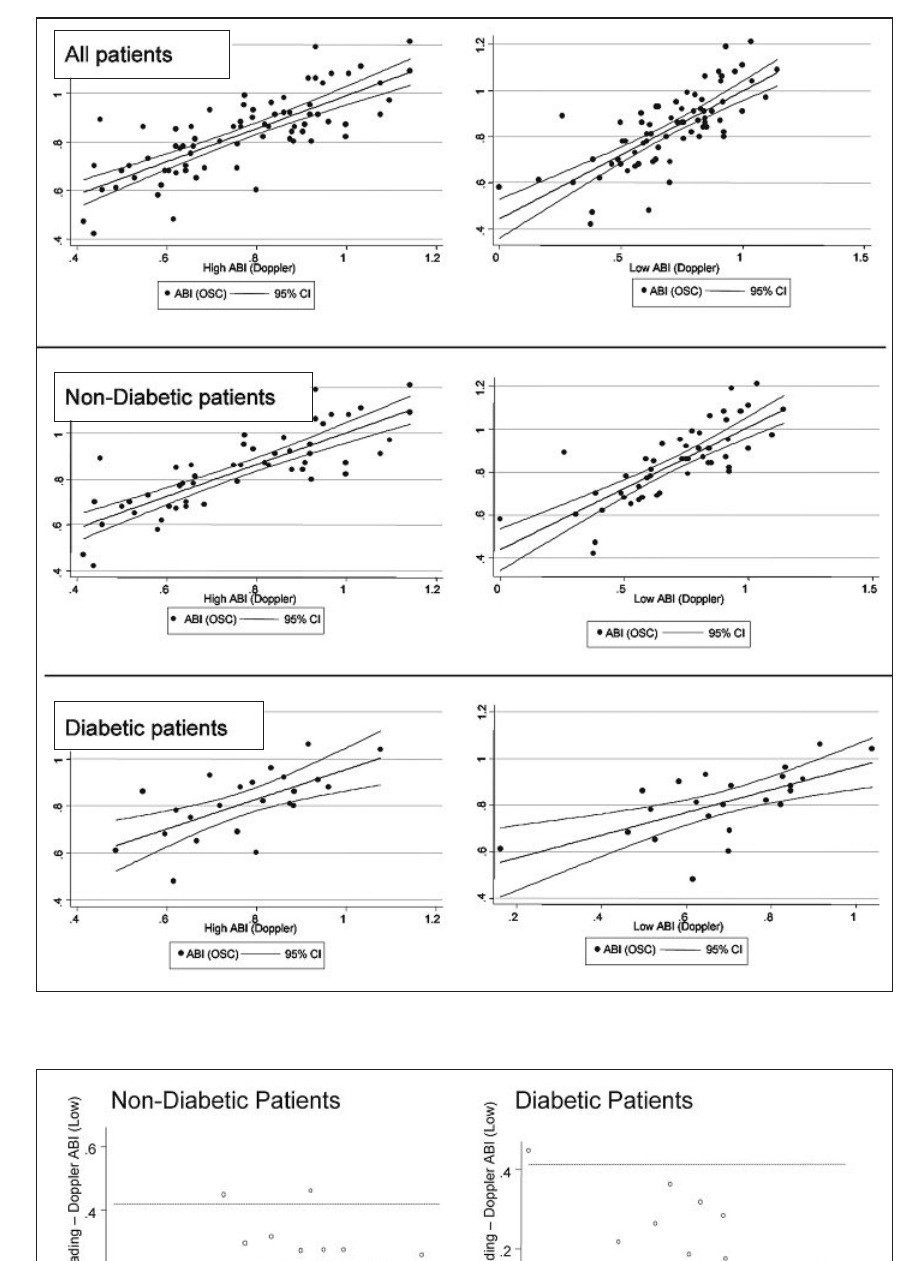
Figure 2 Linear regression analysis of correla- tion between oscillo- metric (OSC) and Doppler-assisted high (left) and low (right) measurement of ankle brachial index (ABI), respectively, including stratifica- tion for presence of diabetes. 95% confi- dence intervals (CI) are indicated for linear regression.